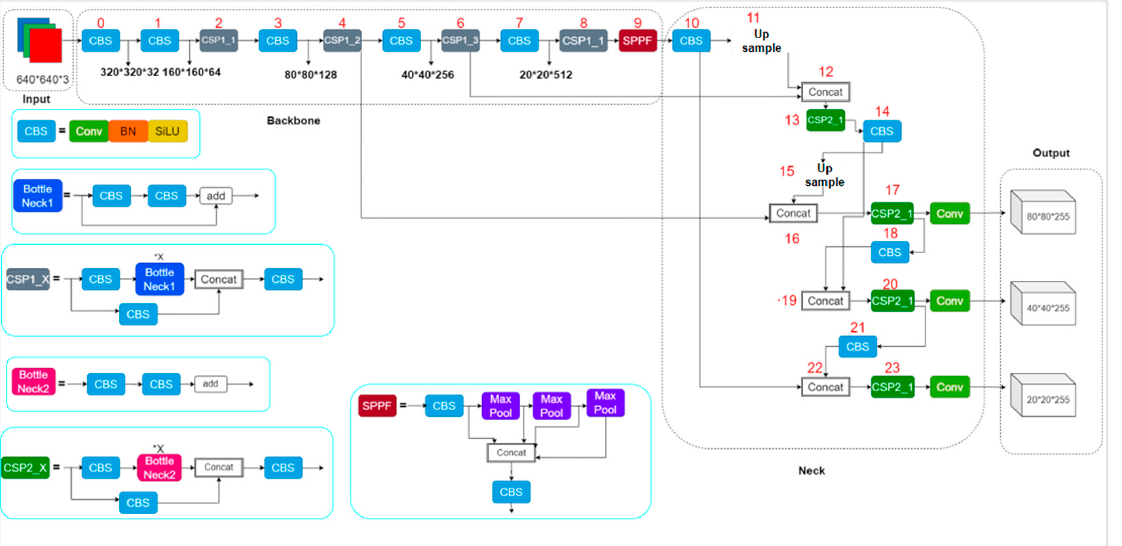
Figure 4. The structure of SPPF.